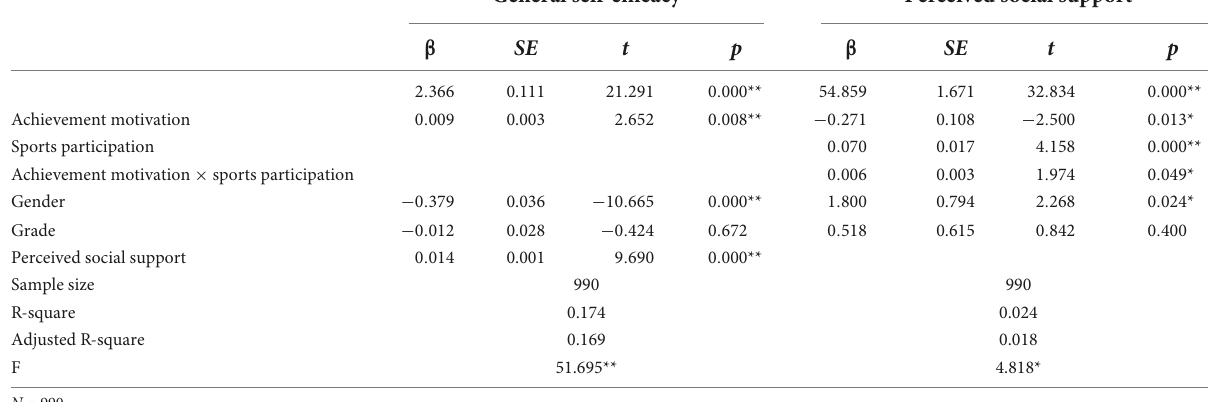
TABLE 6 Results of hierarchical regression analysis.